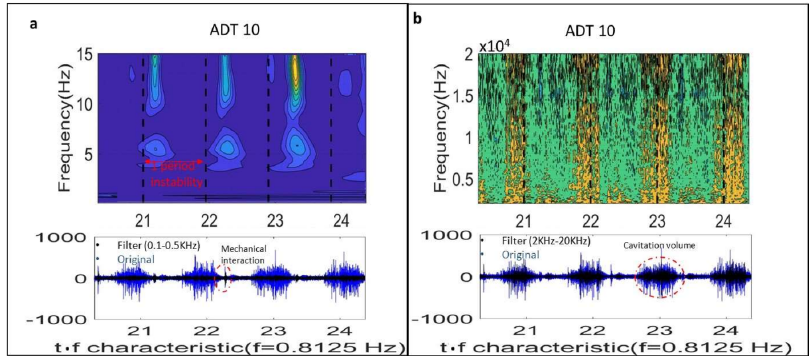
Figure 5. Sensor ADT-high frequency. Mechanical phenomenon of the pressure wave ( a ) and volume of cavitation oscillating ( b ).